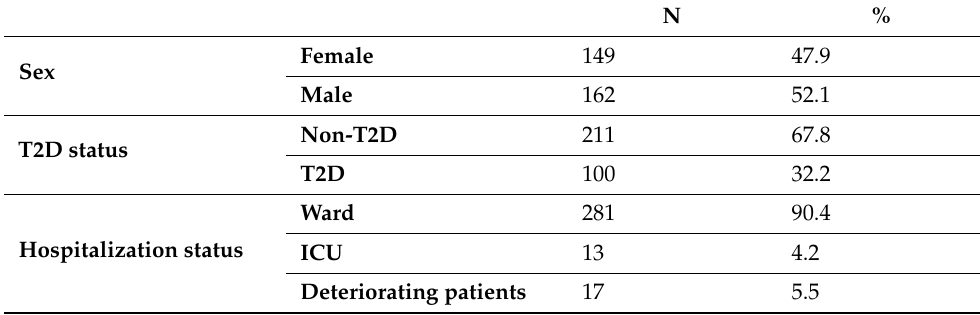
Table 1. Demographic and clinical characteristics of the